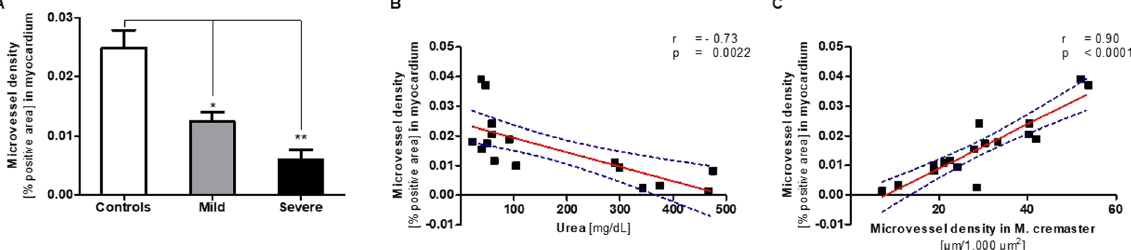
Figure 6. CKD suppresses transcription levels of angiogenesis regulating genes. RNA was isolated from cryoconserved heart tissues from mice (adenine-induced uremia) with mild (n = 10) or severe uremia (n = 6) and controls (n = 13) and gene transcription levels analyzed by RT-PCR and analyzed by Kruskall-Wallis test with Dunn’s test for multiple comparisons post hoc. Shown are individual values (mean ±